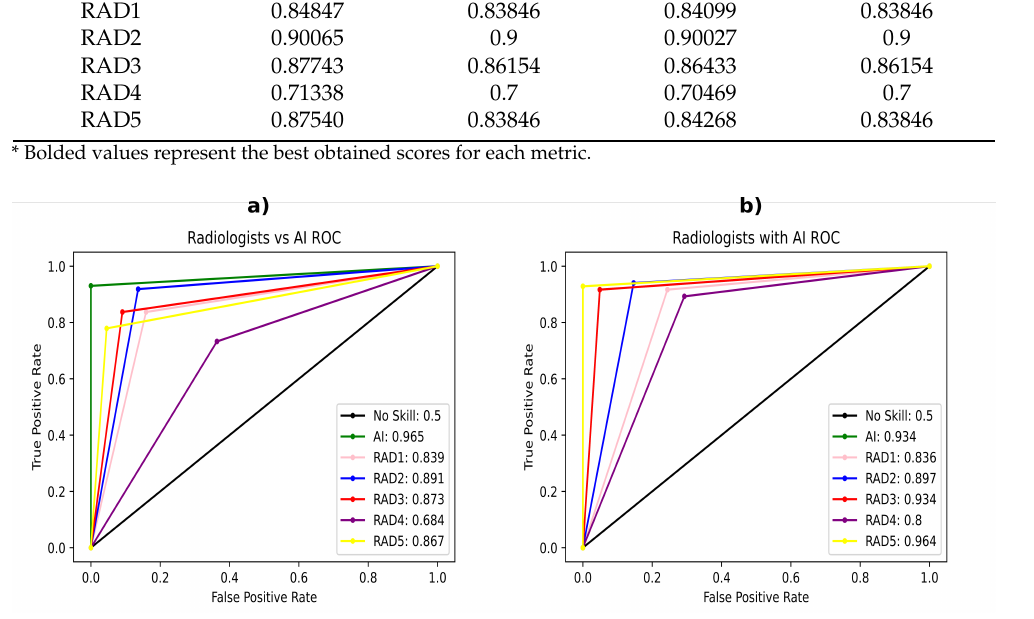
Figure 7. ROC of the AI and radiologists comparisons. In the legend, the AUC ROC is presented for every test subject. ( a ) ROC for radiologist versus AI; ( b ) ROC for radiologist with